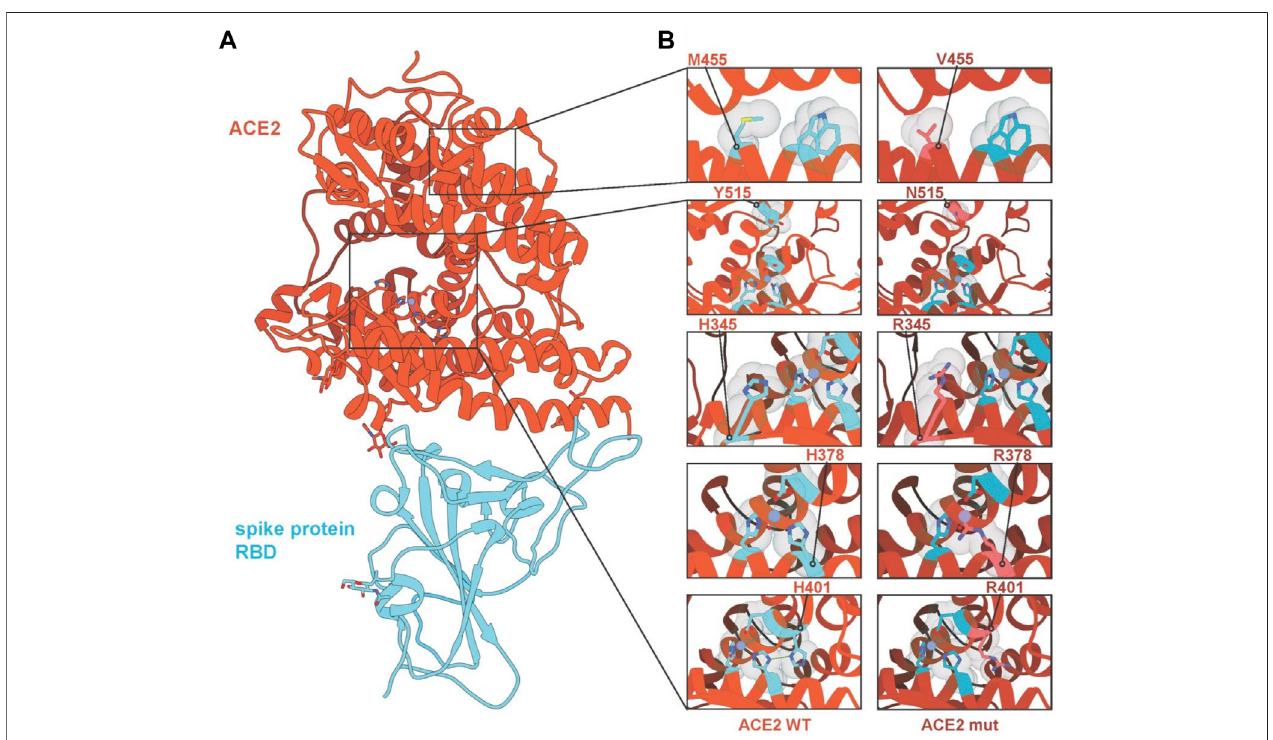
FIGURE3| InteractiondiagramsofACE2variantsandSARS-CoV-2S-protein. (A) CrystalstructureofACE2andSARS-Cov-2Sprotein(pdbidenti fi er:6LZG)with ACE2 coloured in red-orange and the RBD domain of the SARS-CoV-2 S protein in light blue. Regions of interest are highlighted and expanded in panel (B) , showing mutatedresiduesM455V,Y515N,H345R,H378RandH401Rwithwild-typesequences(left)andmutatedsequences(right).Hydrogenbondsareshowningreen,Zinc ions are shown in purple, and water molecules are shown in